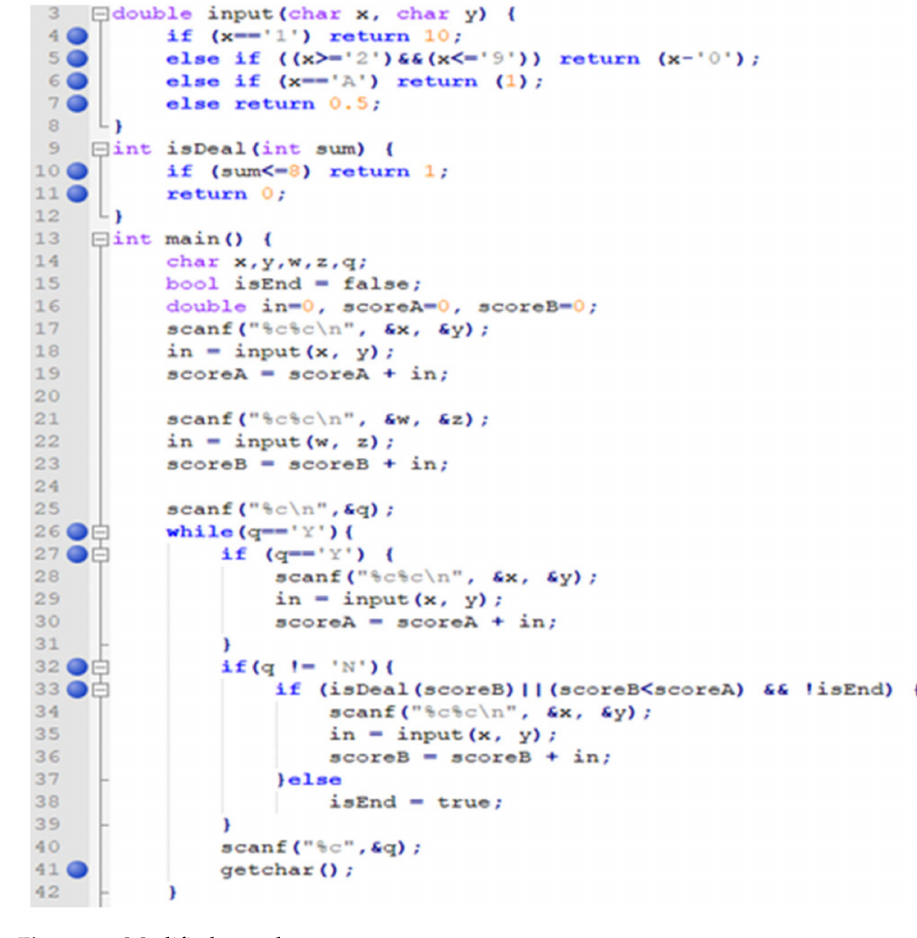
Figure 32. Modified sample program.